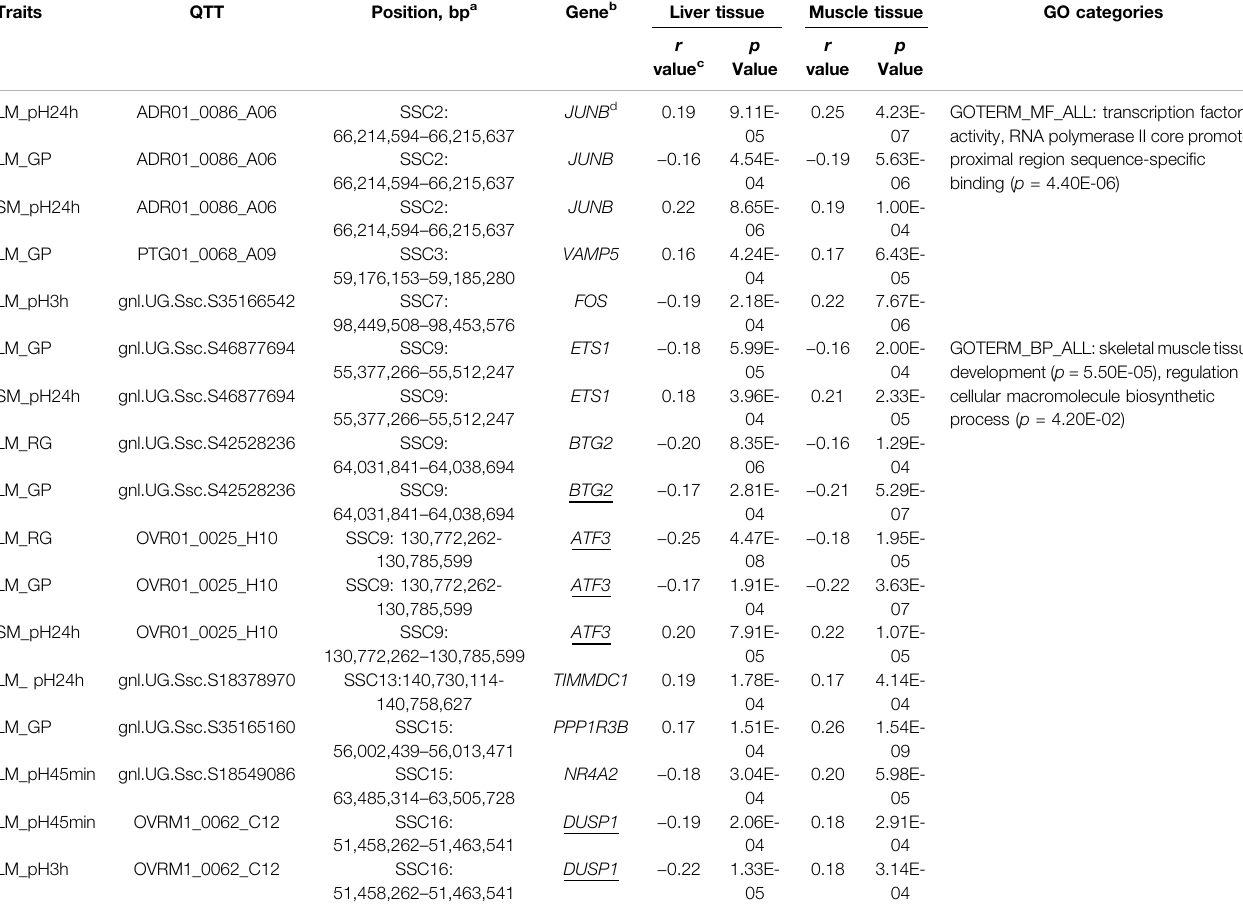
TABLE 3 | Ten candidate genes were identi fi ed to have GP- or pH-associated transcripts in both liver and muscle. Traits QTT Position, bp a Gene b Liver tissue Muscle